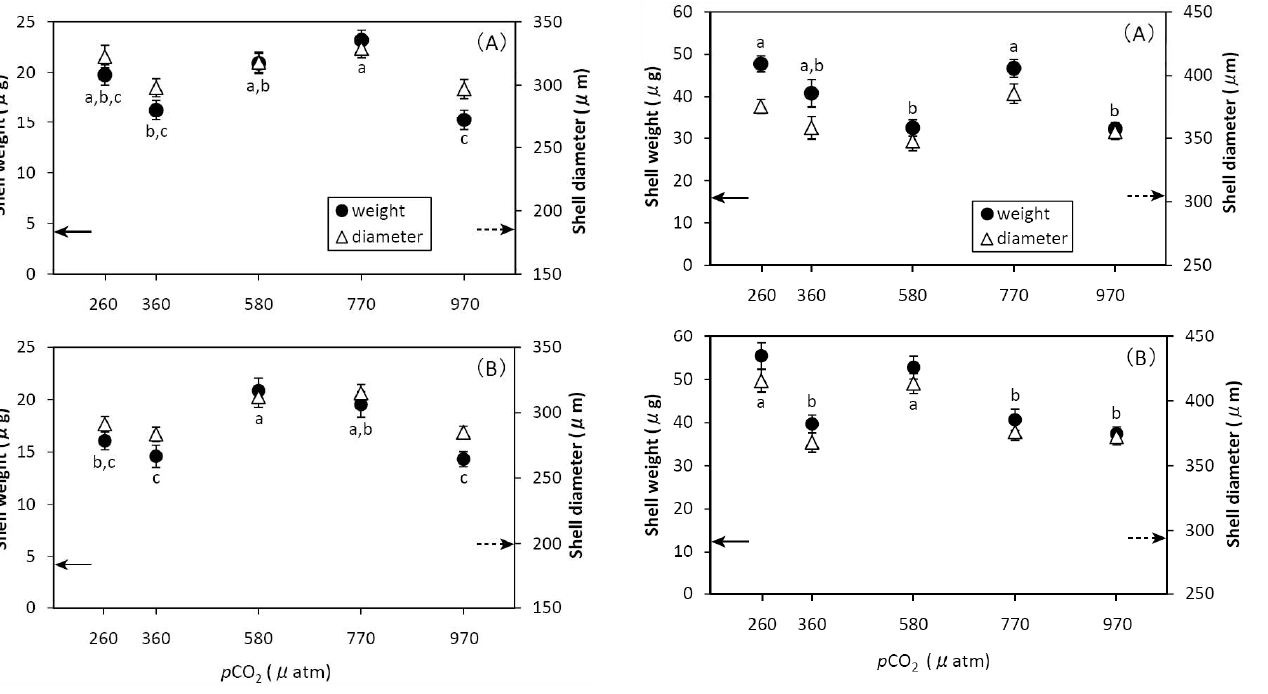
Fig. 3. Mean shell diameter and weight of Baculogypsina sphaeru- lata after culture for about 12 weeks at five p CO 2 levels. Values are means ± SE of the 20 clone individuals sampled in each treatment. Different letters above plotted treatment values indicate a signifi- cant difference ( α = 0.05) in shell weight according to Tukey’s HSD post hoc test. Dashed and solid arrows show mean shell diameter and mean weight of clone individuals, respectively, at the start of the experiment. (A) Population α , (B) population β .